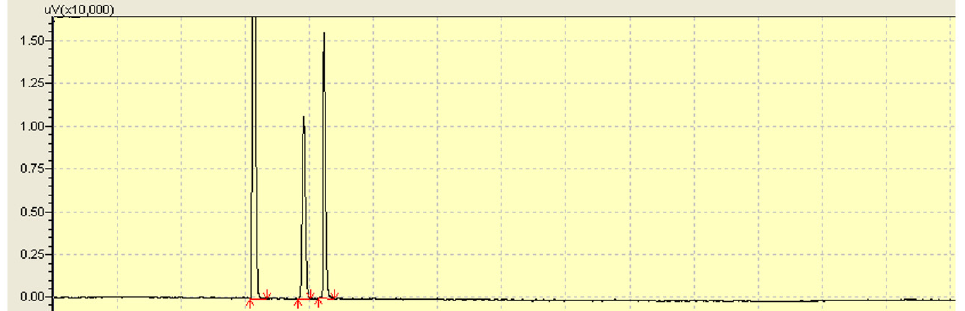
Figure 11. Original GC-map of CO 2 reduction products distribution. Conditions: 0.1 MPa CO 2 , 0.5 mL H 2 O, concentrating ratio of 800.